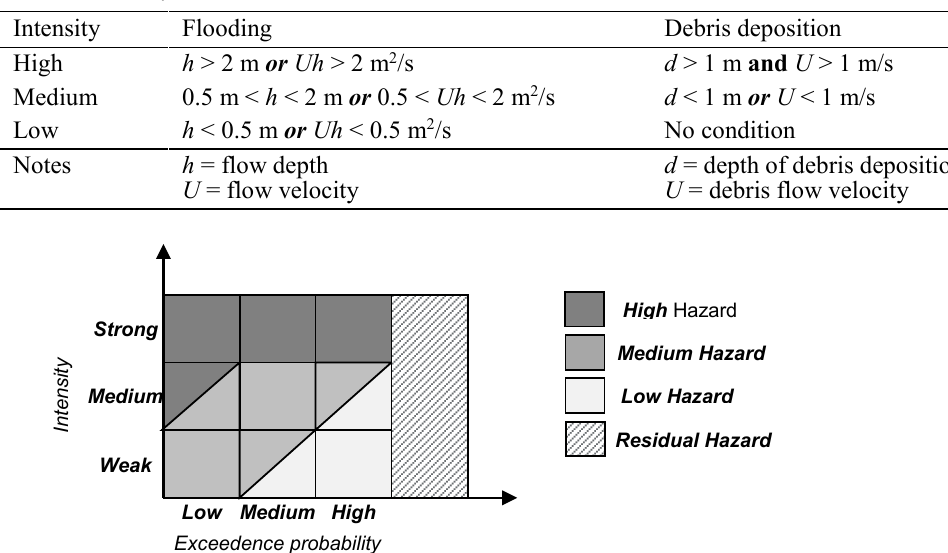
Fig. 2 Matrix for hazard levels assessment in the Swiss methodology where grey scale is adopted instead of the original yellow, blue, red and yellow-white hatched